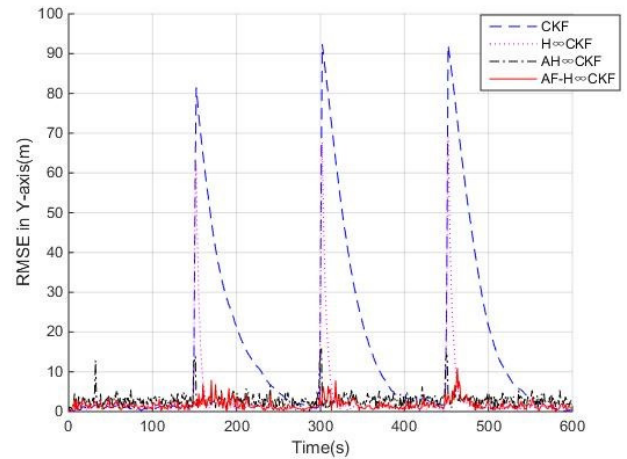
Figure 3. RMSE in the Y-axis in Case 1.